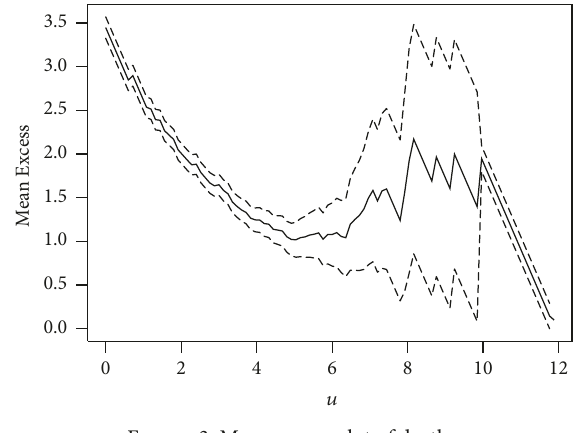
Figure 3: Mean excess plot of deaths. Table 1: POT parameters estimates.